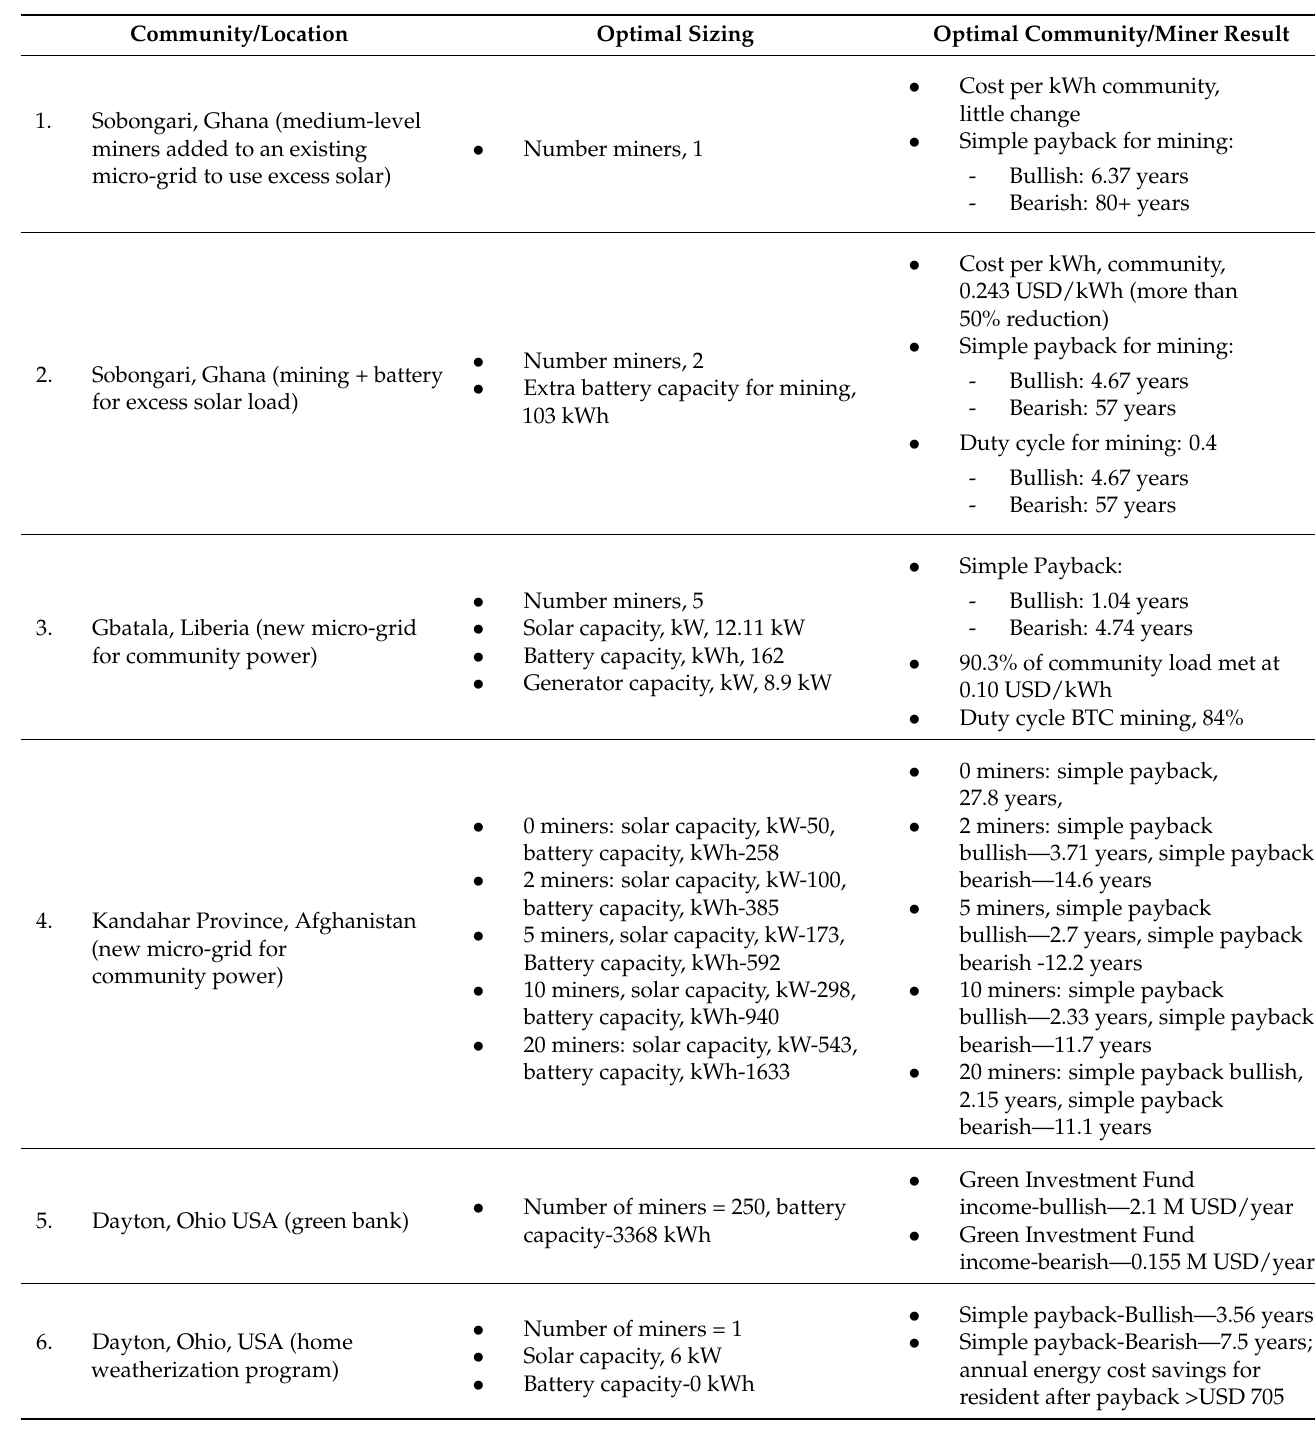
Table 3. Results for cases